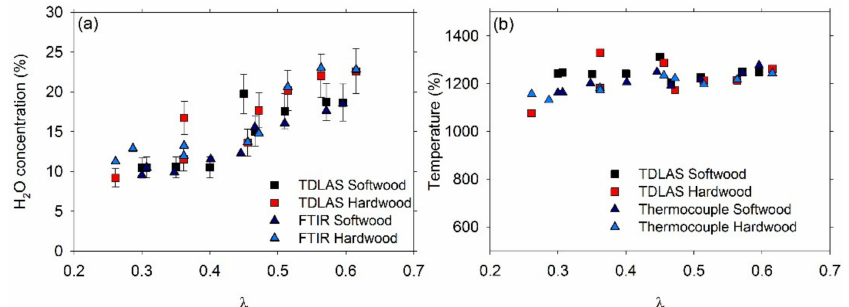
Figure 9. The average water concentration ( a ) and average temperature ( b ) for λ ratios between 0.25–0.65 of the two tested fuels. Measurements with TDLAS (tunable diode laser absorption spectroscopy), FTIR (Fourier-transform infrared spectroscopy), and thermocouple (type